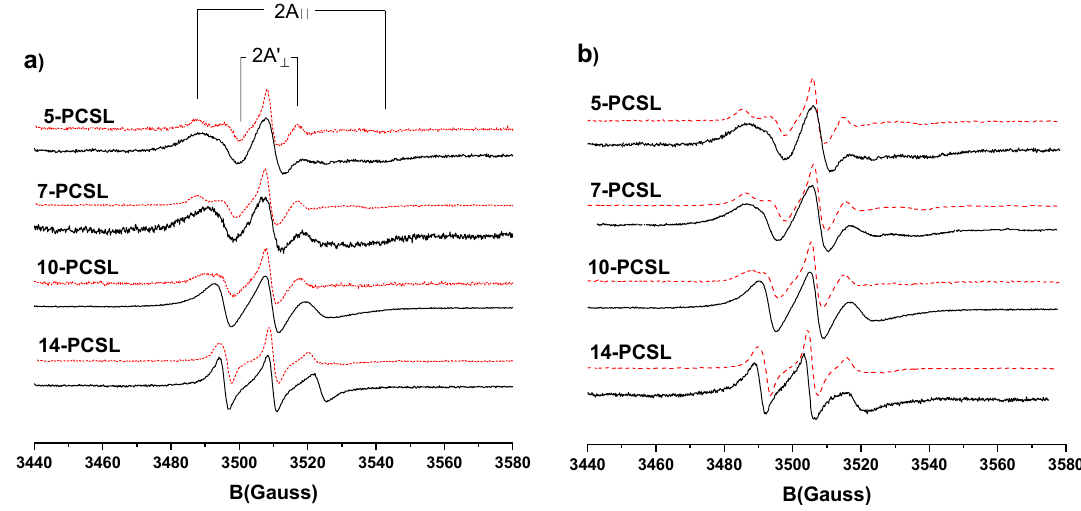
Figure 3. ( a ) Electron paramagnetic resonance (EPR) spectra of n-PCSL in POPE-POPG-Span 80 water/dodecane emulsions (solid black line) and in POPE-POPG-Span 80 vesicles (dotted red line). ( b ) EPR spectra of n-PCSL in POPE-POPG water/squalene emulsion (solid black line) and in POPE-POPG (dotted red line) vesicles.